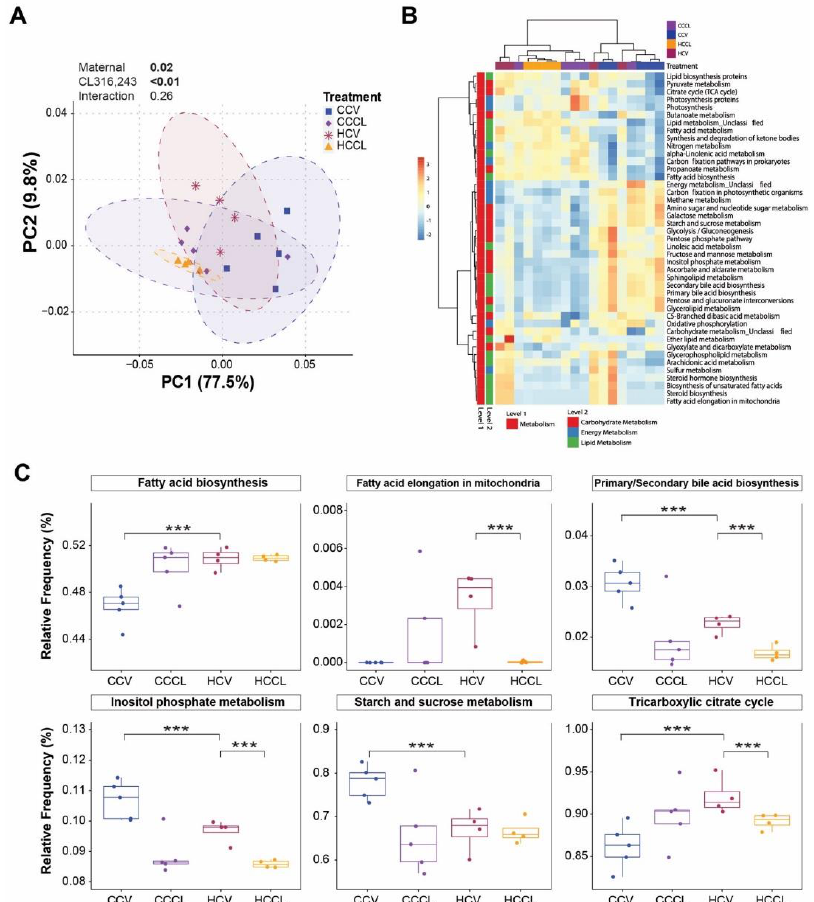
Figure 5. Distinct PICRUSt-predicted functional profiles in the mice gut driven by maternal diet and CL316,243 challenge. ( A ) Principal coordinate analysis plot based on Bray − Curtis dissimilarities generated from the pathways relative abundance. Axes show the first two principal components and their corresponding percentage of variance explained. Ellipses define the 95% confidence level. ( B ) Heatmap of pathways related to carbohydrate, energy, and lipid metabolism. ( C ) Significantly different metabolic-related pathways across treatments. Statistically significant p -values are bolded. CCV = offspring from control diet-fed dams treated with vehicle (n = 5); CCCL = offspring from control diet-fed dams treated with CL316,243 (n = 5); HCV = offspring from high fat diet-fed dams treated with vehicle (n = 4); HCCL = offspring from high fat diet-fed dams treated with CL316,243 (n = 4). Nonparametric multiple comparisons (*** p < 0.001).